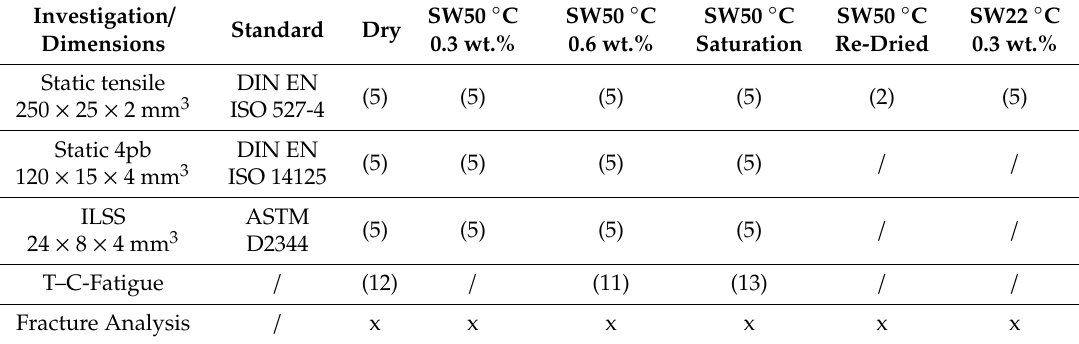
Table 2. Experimental testing scheme, specimen dimensions, and number of tested samples (brackets). Fracture analysis was performed for all configurations